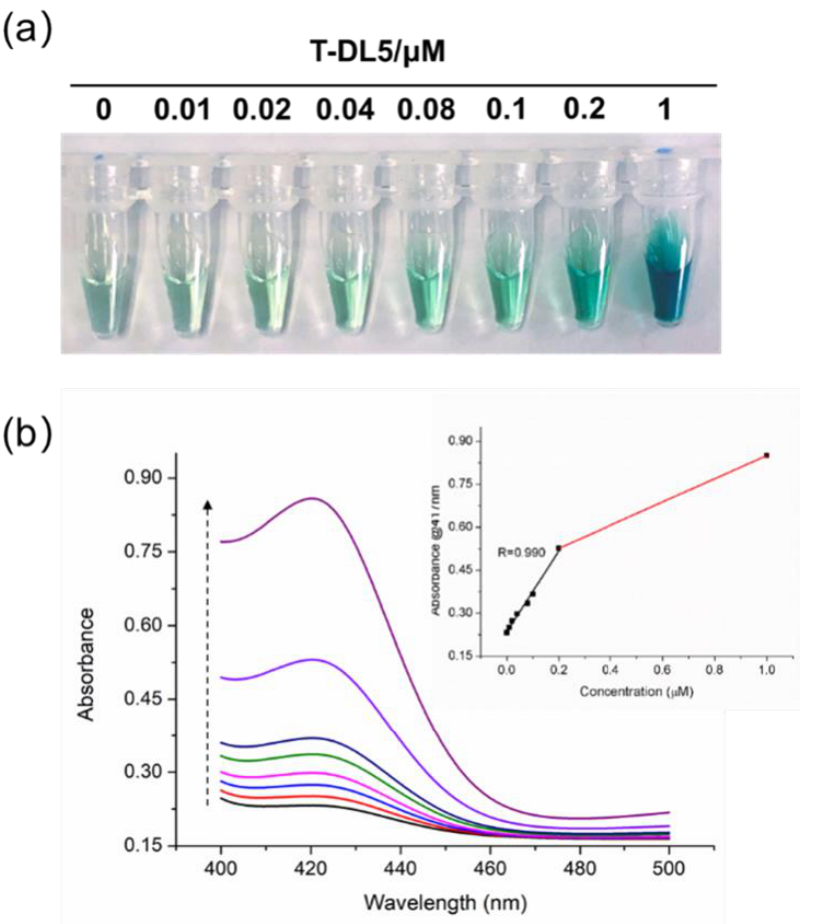
Figure 5. ( a ) Colorimetric observation and ( b ) UV absorbance of 0–1 µ M T-DL5 in the presence of 1 µ M P1-5 and 1 µ M P2-5 in colorimetric buffer. The inner panel in ( b ) illustrates the linear fitting of UV absorbance at 417 nm with 0–0.2 µ M T-DL5.